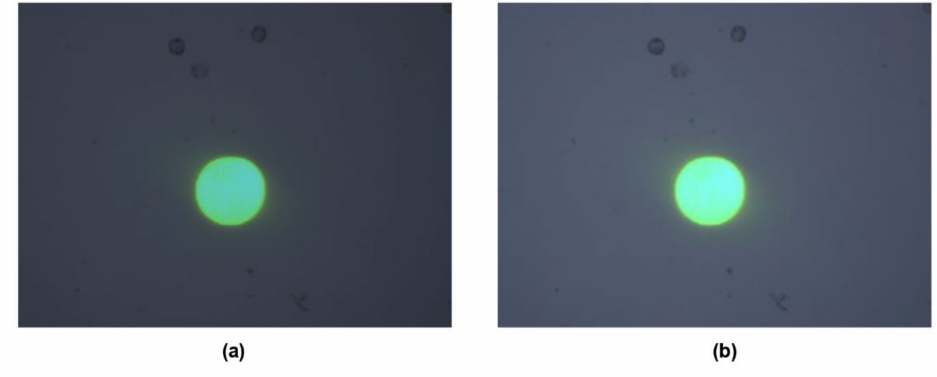
Figure 5. ( a ) Original cell image taken by CCD and ( b ) cell image with dark corners removed.